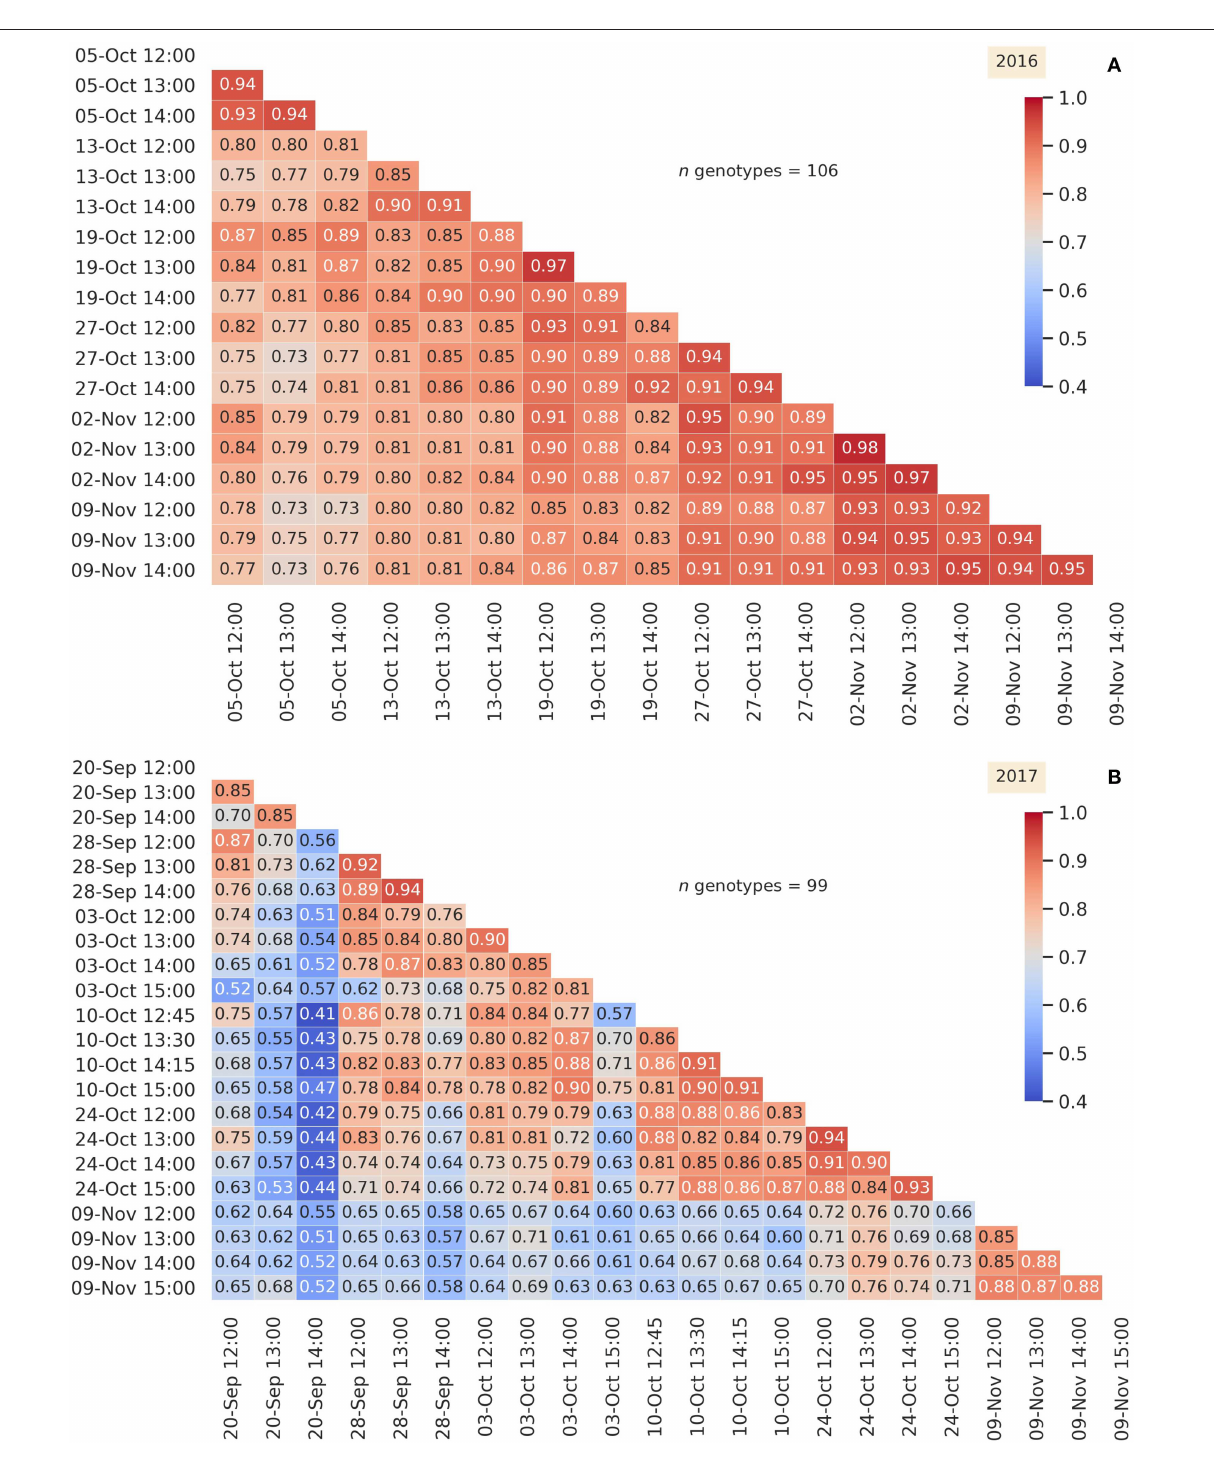
in 2016, evidence of a strong genotypic effect across years. The two days in 2017 where the correlations were greatest (28-Sept- 17 and 10-Oct-17), occurred soon after irrigation or rain (24